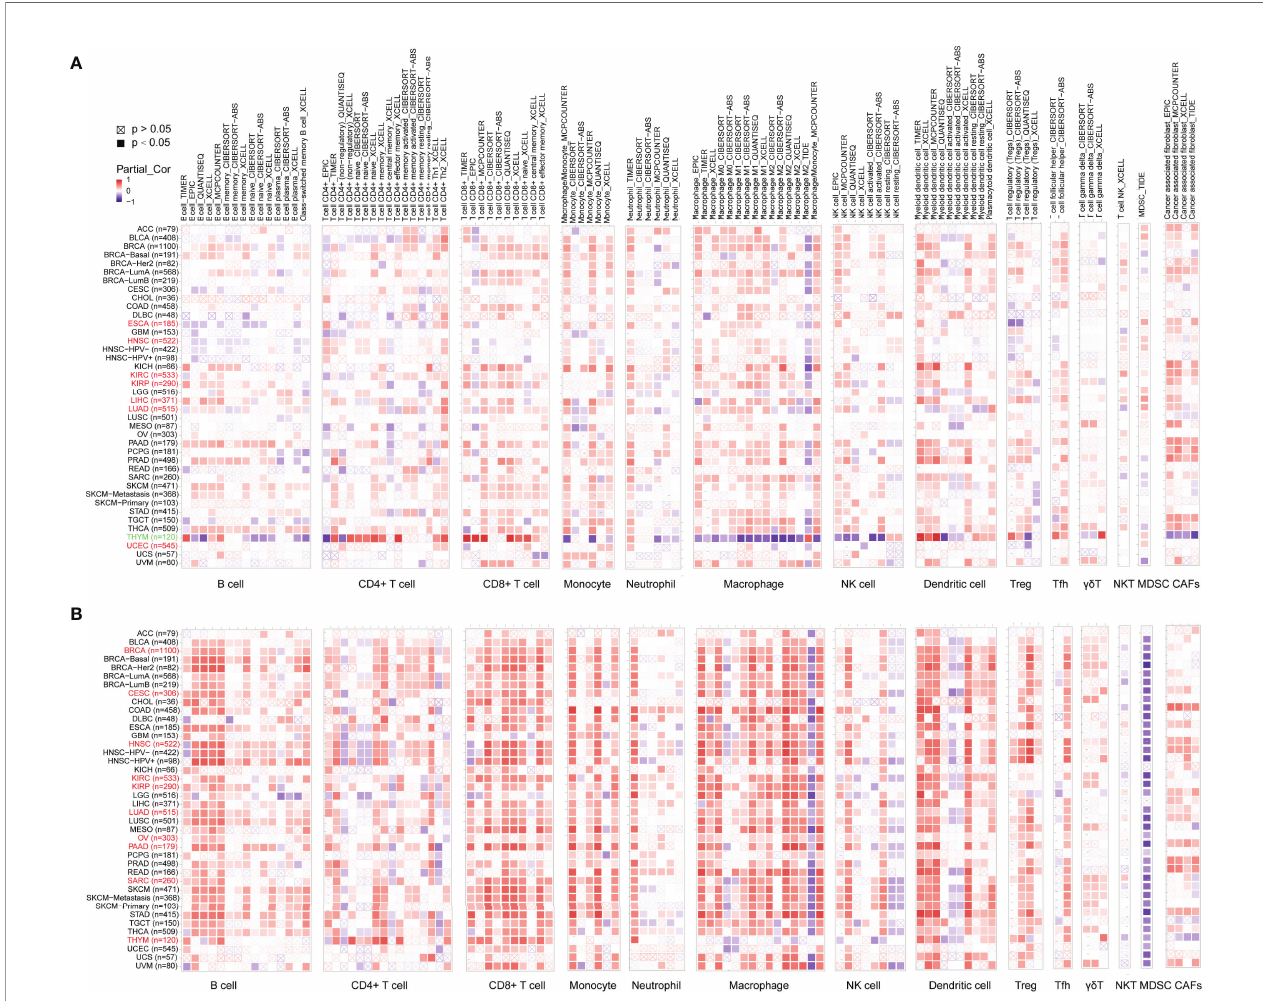
FIGURE 4 | Associations of ADA1 and ADA2 expression with immune in fi ltration. (A) The correlations between ADA1 expression and immune in fi ltration in cancers. (B) The correlations between ADA2 expression and immune in fi ltration in